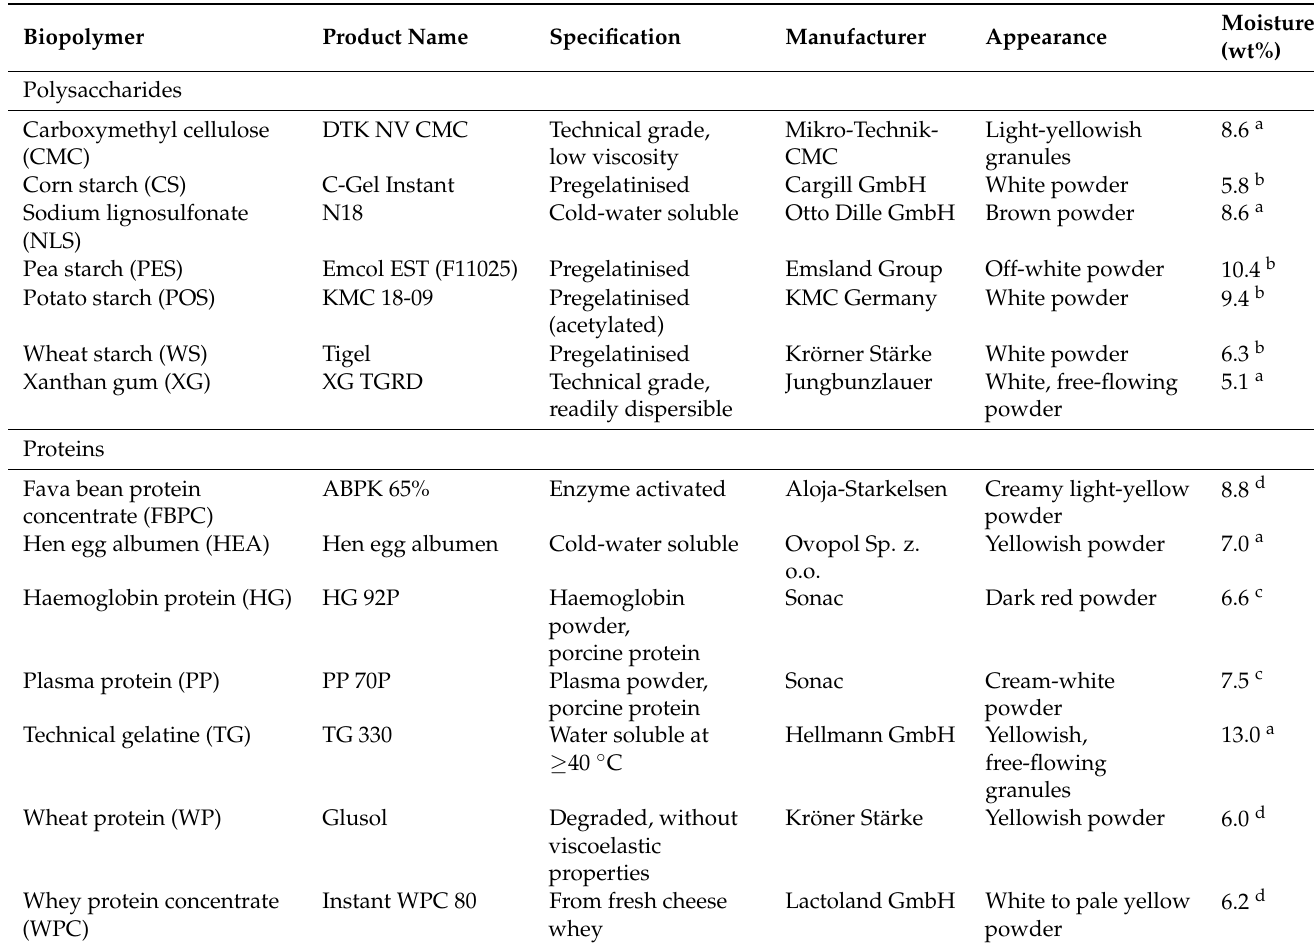
Table 2. Biopolymers investigated by this study and their product